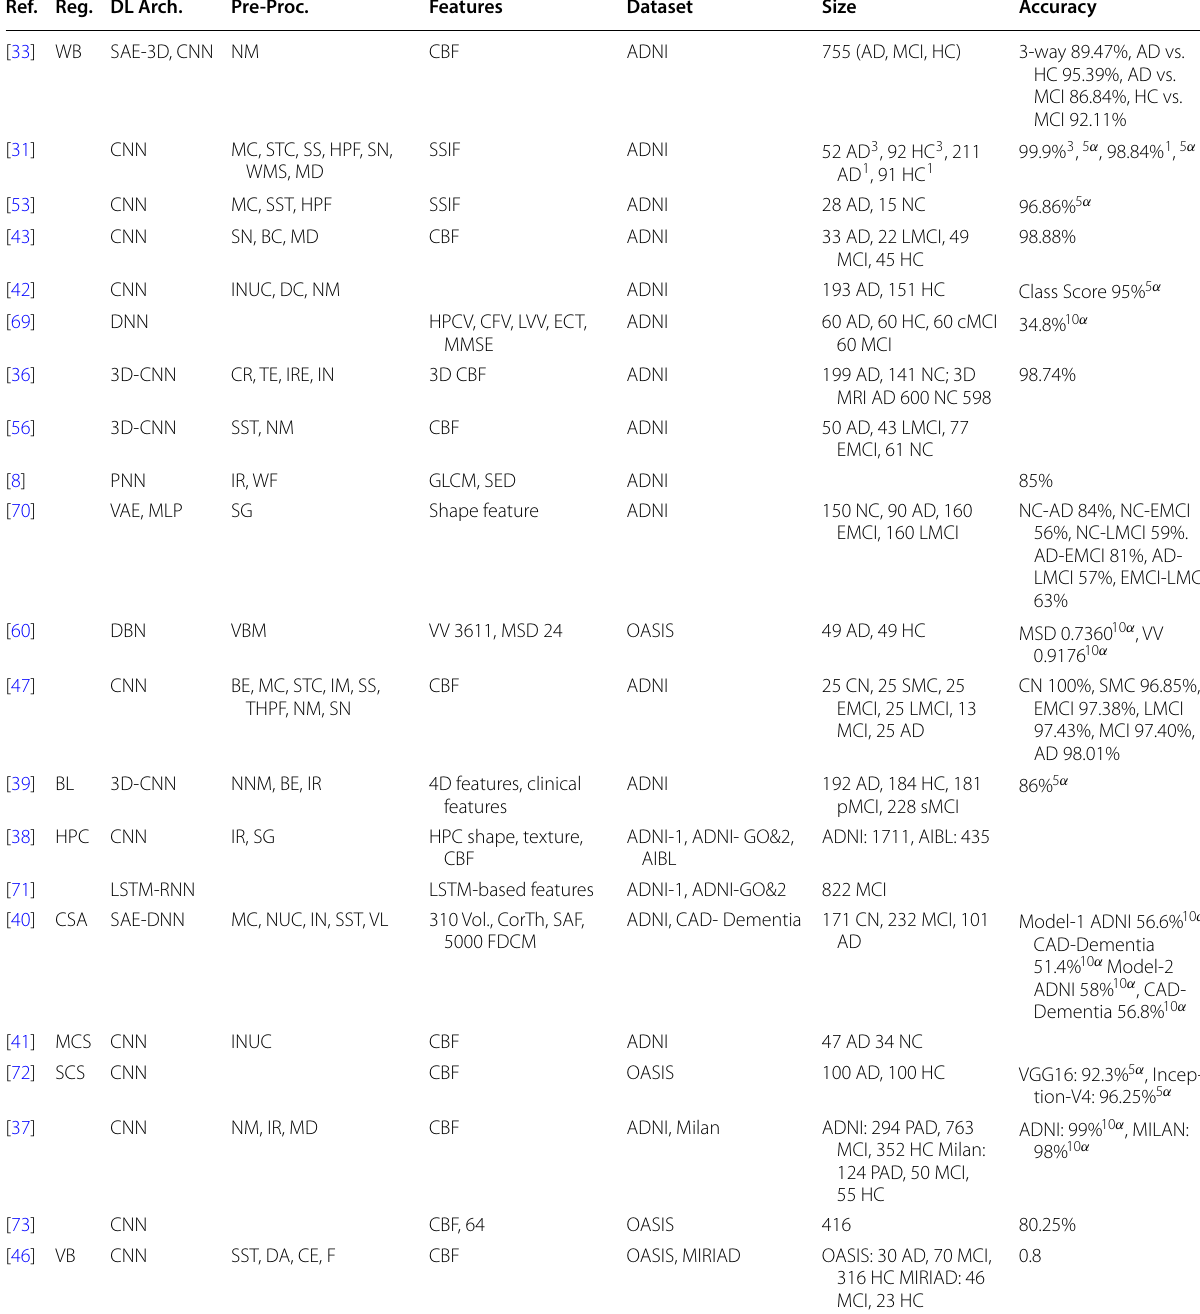
Table 2 Summary of DL‑based studies for prediction and classification of AD from MRI Ref. Reg. DL